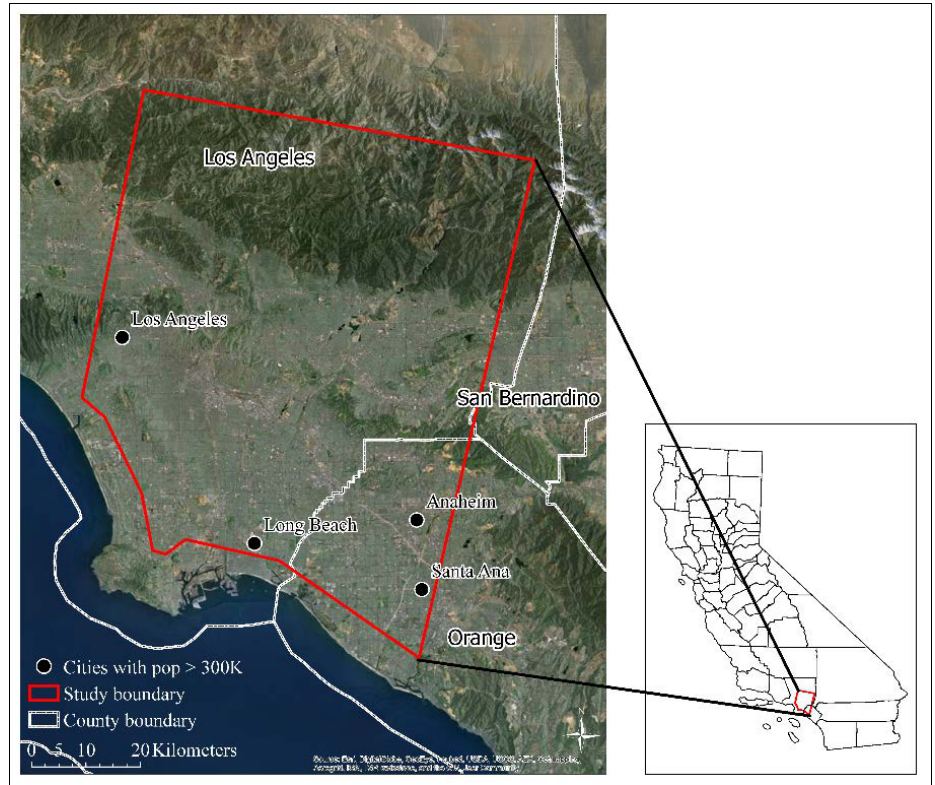
Figure 1. Geographical location of the study area.